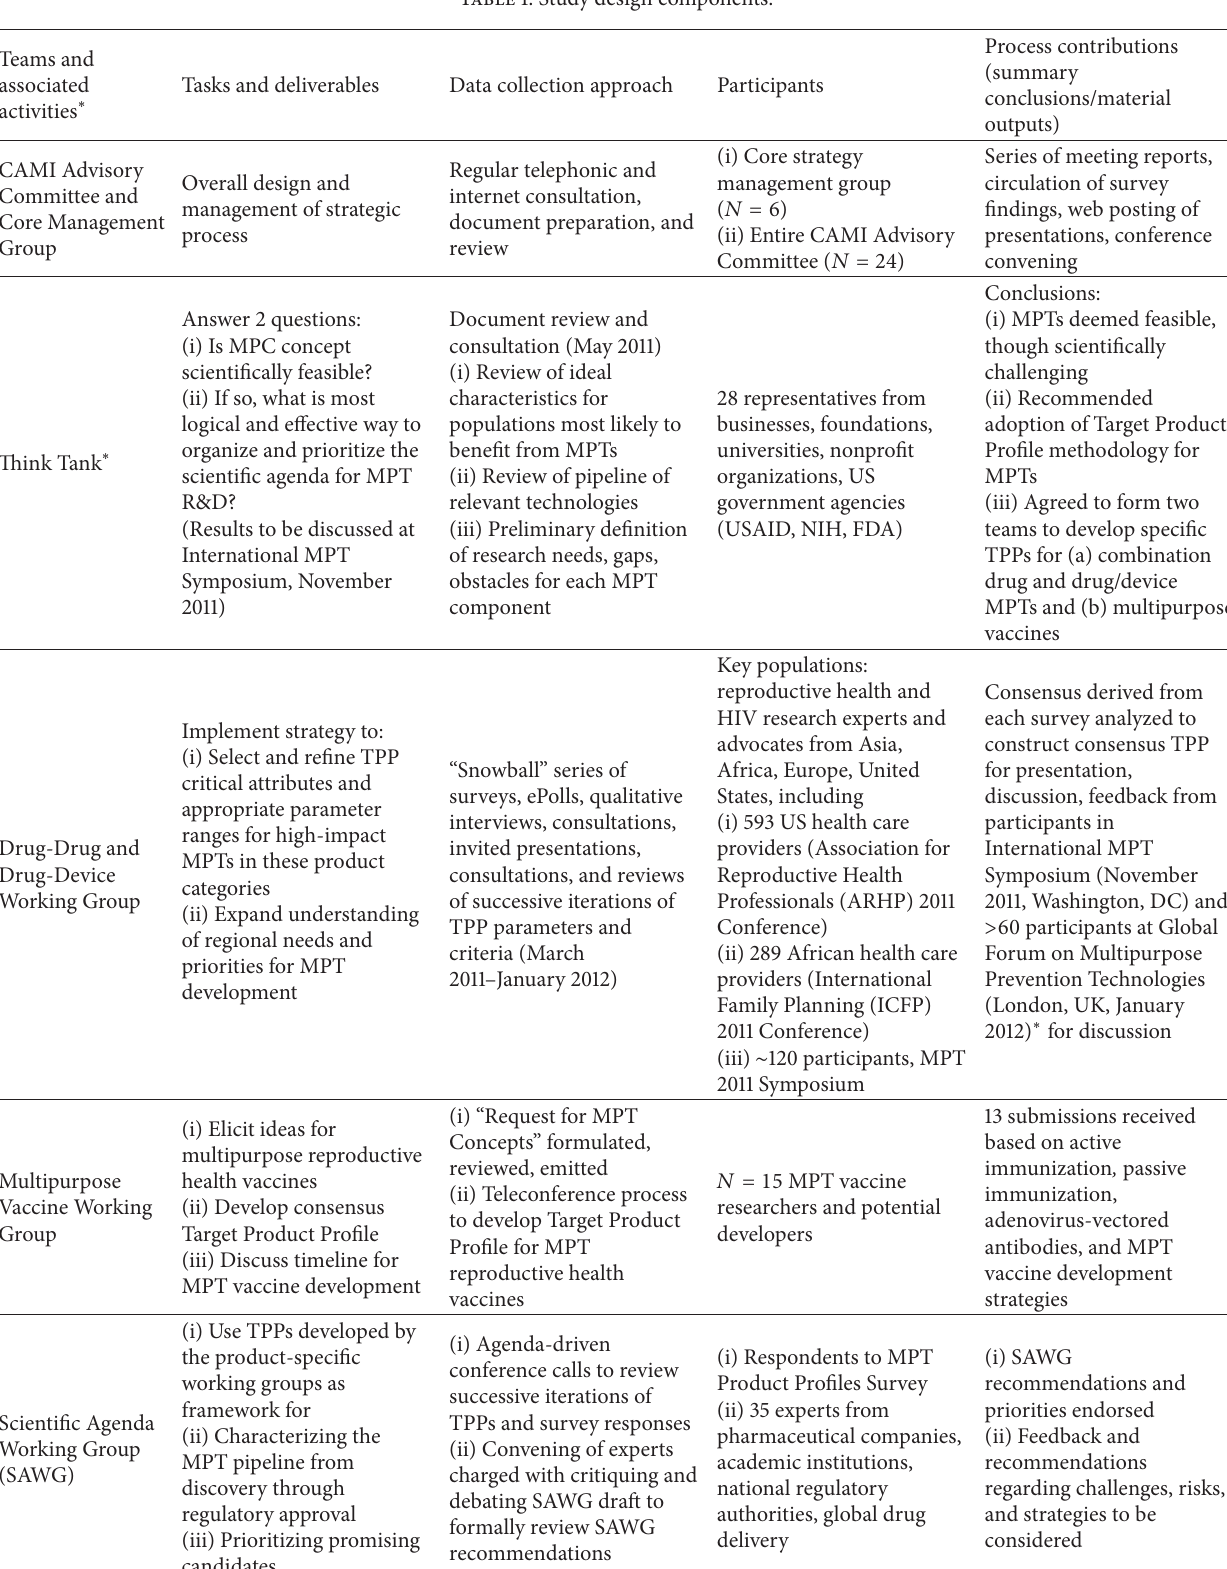
Table 1: Study design